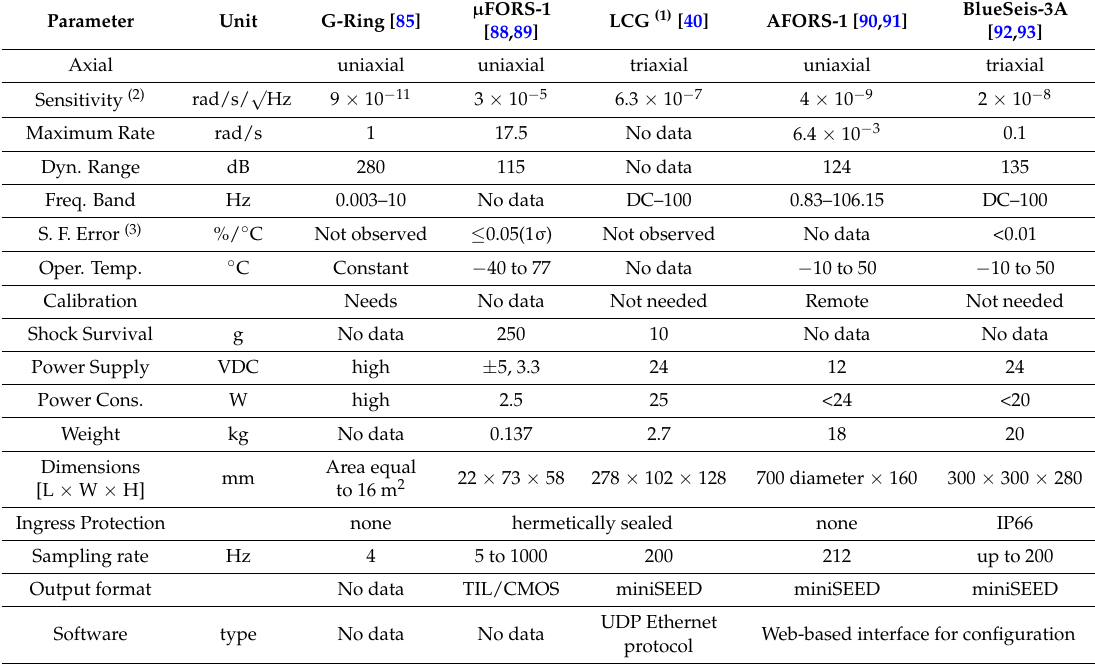
Table 3. Overview of optical rotational seismometers with RLG and FOG configurations (only the most important parameters have been